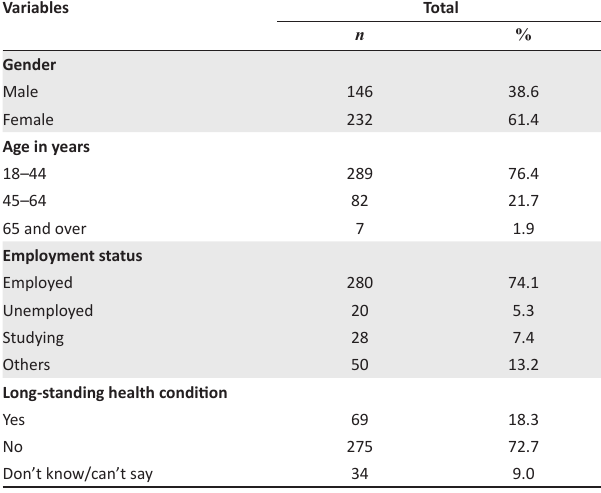
TABLE 2: Socio-demographic characteristics and health status of the patients ( N = 378).